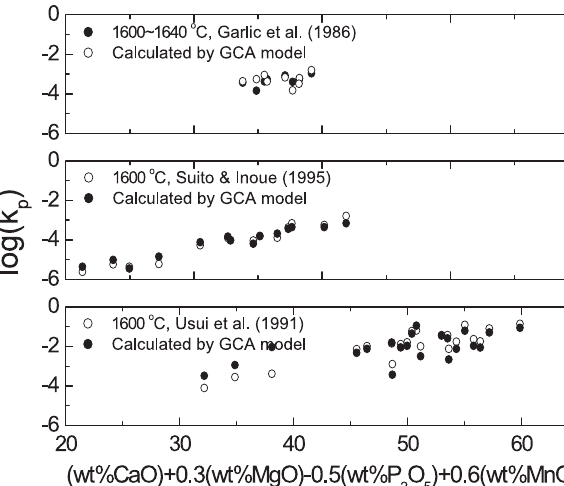
Fig. 5: Comparison of the model calculated log(k p ) for the MnO containing steelmaking slags with the experimental data [22, 26, 32].